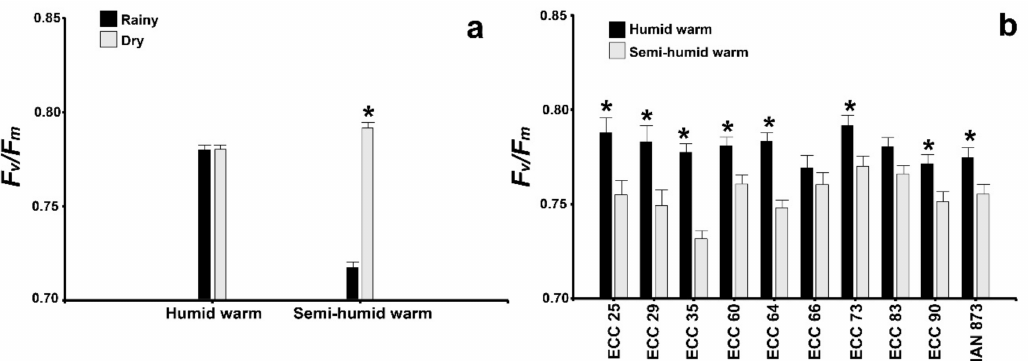
Figure 3. Maximum photochemical efficiency of PSII ( F v /F m ) for the significant interactions between site and period ( a ), and genotype with site ( b ). Means estimated for the rainy and dry periods for each site (humid warm and semi-humid warm) and for the sites followed by an asterisk (*) for each genotype were significantly different according to Fisher’s LSD test, ( p < 0.05). Values represent the mean ± SE of four replications for the 10 genotypes ( n = 40) ( a ), or of four replications for the two periods ( n = 8) ( b